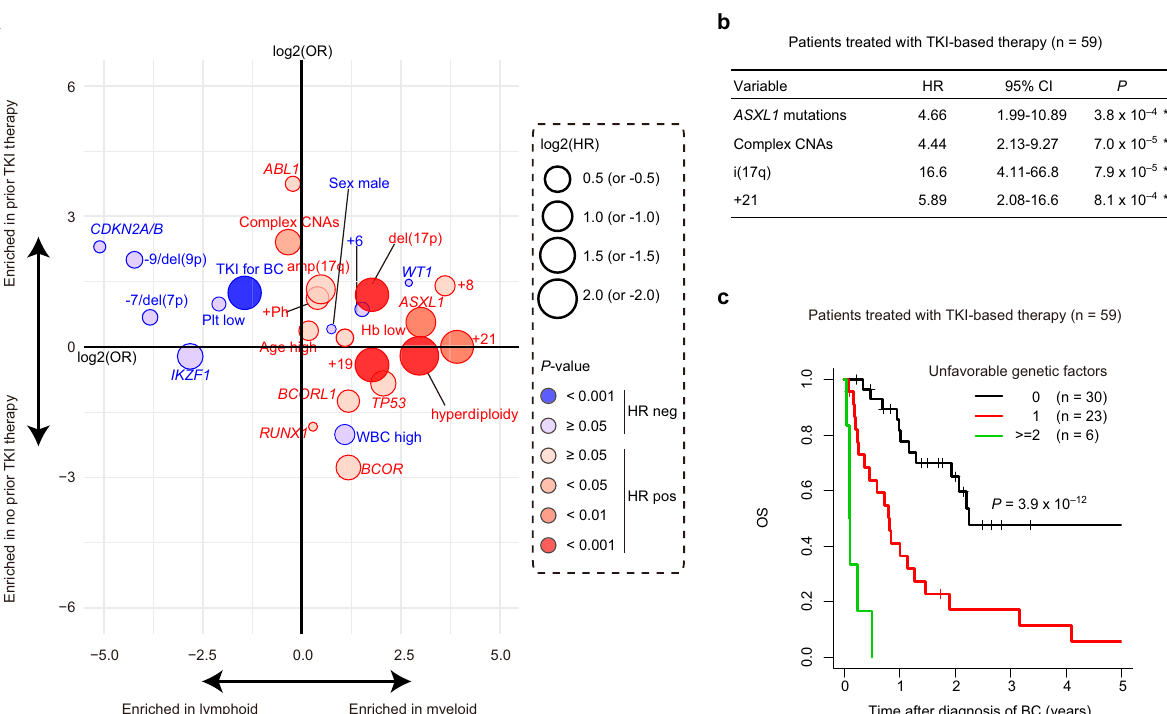
Fig. 5 Prognostic impact of each clinical or genetic factor in CML-BC. a Summary of the relationship between individual clinical or genetic factors and lineage of BC, prior TKI history, and OS in 99 BC patients. Odds ratios for the enrichment of individual factors in myeloid lineage of BC and in the history of prior TKI therapy are represented in the horizontal and vertical axes, respectively. The size of the circles corresponds to the hazard ratio (HR) of the effect of each factor on the OS in the univariate analysis. Positive and negative HR values are shown as red and blue circles, respectively. The colour gradient indicates P values calculated by the Cox proportional hazards regression model in the univariate analysis. b Cox proportional hazards regression model with a stepwise variable selection identifying the independent risk factors, predicting OS in 59 patients treated with TKI-based therapy for BC. *** P < 0.001. c Kaplan – Meier survival curves for OS of 59 patients treated with TKI-based therapy for BC according to the number of unfavourable genetic factors listed in b . P values were calculated using the log-rank